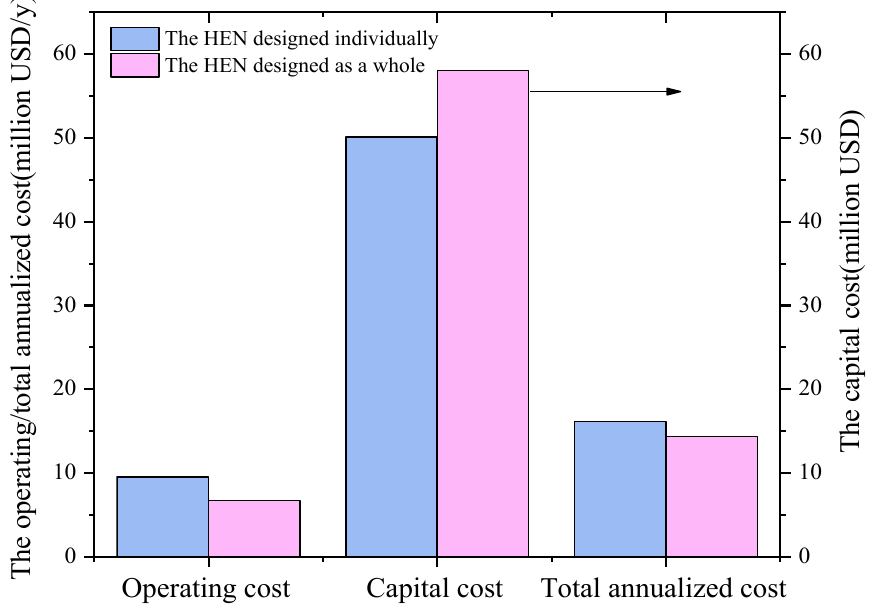
Figure 10. Cost comparison of HENs designed individually and as a whole.